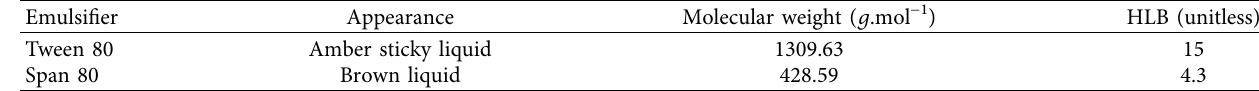
Table 8: Properties of tween 80 and span